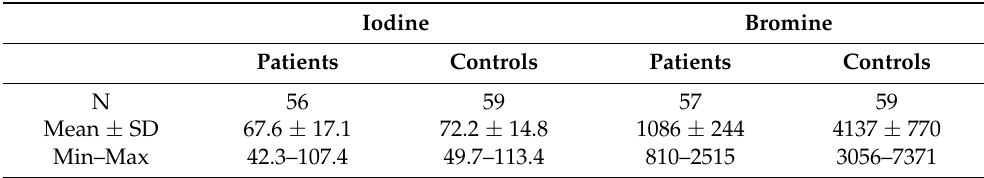
Table 1. Summary of the results: serum iodine and bromine levels ( µ g/L) in patients on chronic hemodialysis therapy and in a control